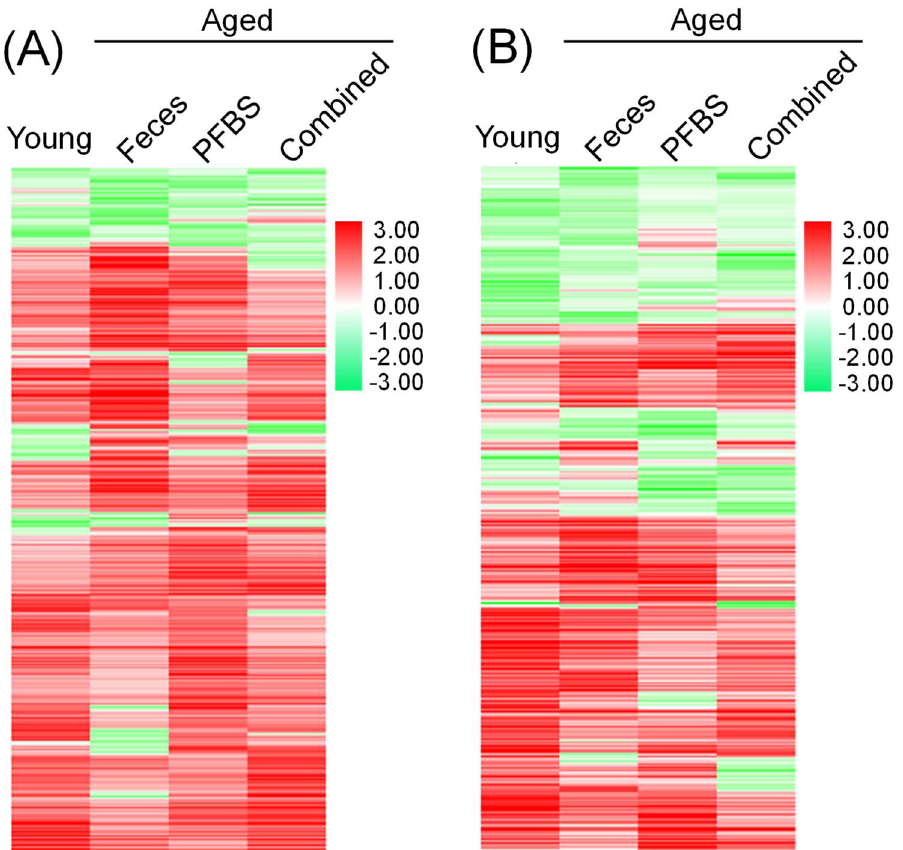
Figure 2. A heatmap showing the overall changes in differential genes among exposure groups in male ( A ) and female ( B ) zebrafish. Red and green colors stand for increased and decreased changes, respectively, compared to the aged−control abundance. Color intensity is proportional to the changing magnitude. Values are presented as means of three replicates ( n = 3).